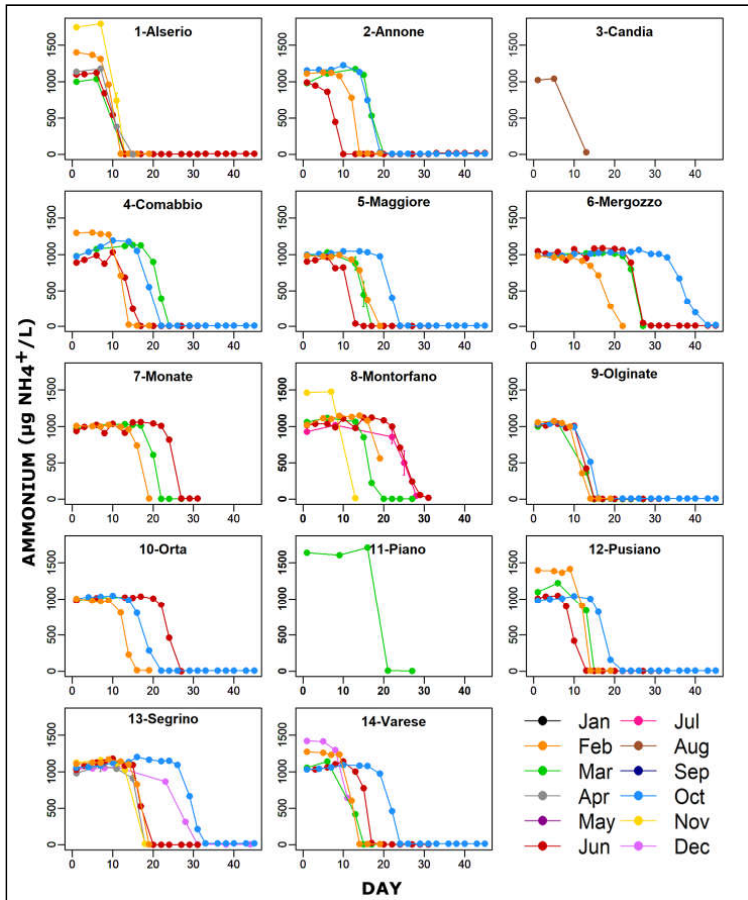
Figure 2. Ammonium oxidation trends in lab-microcosms filled with water of 14 south-alpine lakes sampled in different months and amended with 1 mg /L of NH 4+ . Results are expressed as mean ±SEM for duplicate tests. Note that the SEM bars in most of cases showed low values.